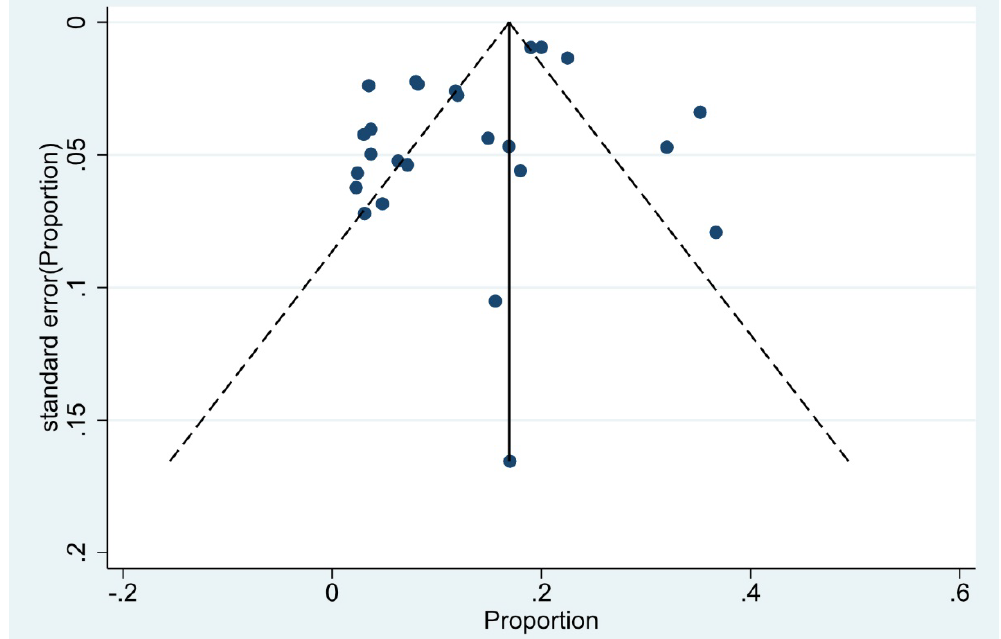
Figure S2. Funnel plot with pseudo 95% confidence